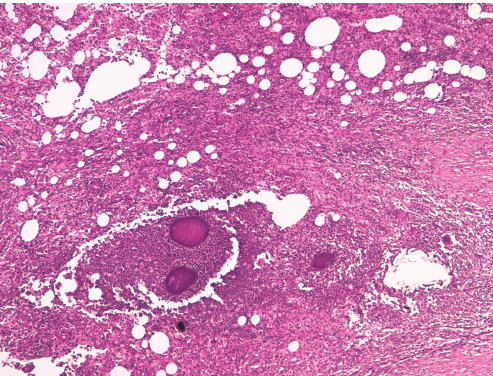
Figure 4: The inflammation was composed by fibroblasts, xan- thomatous cells, and neutrophilic granulocytes, H&E 20x.